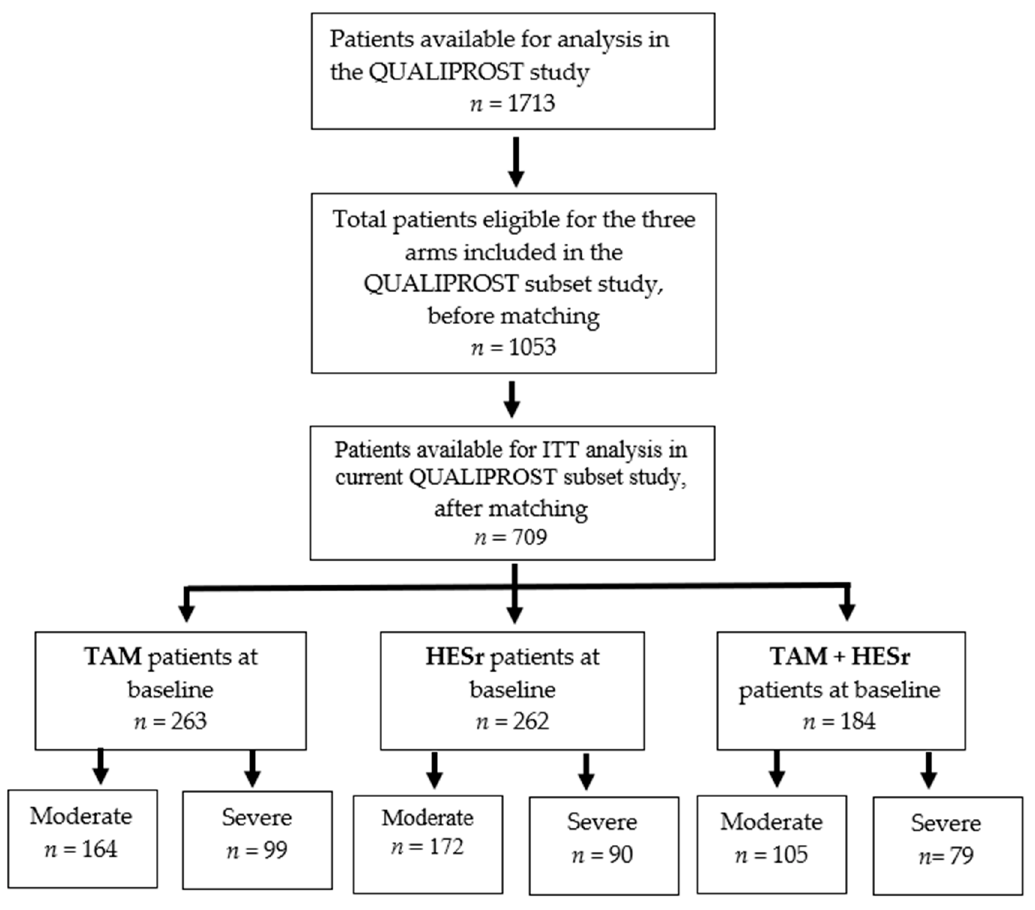
Figure 1. Study flow-chart.